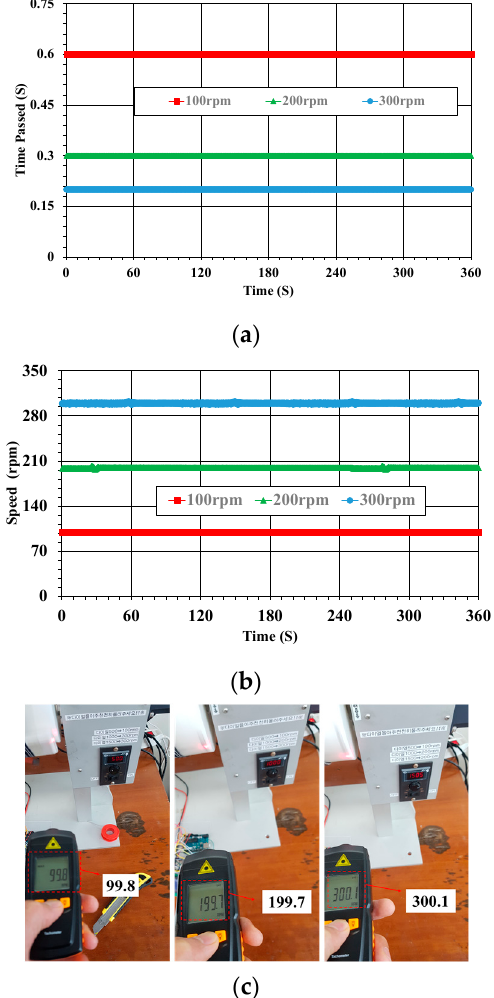
Figure 6. Calculated Time Passed ( a ), the shaft speed ( b ), and tachometer test results ( c ).